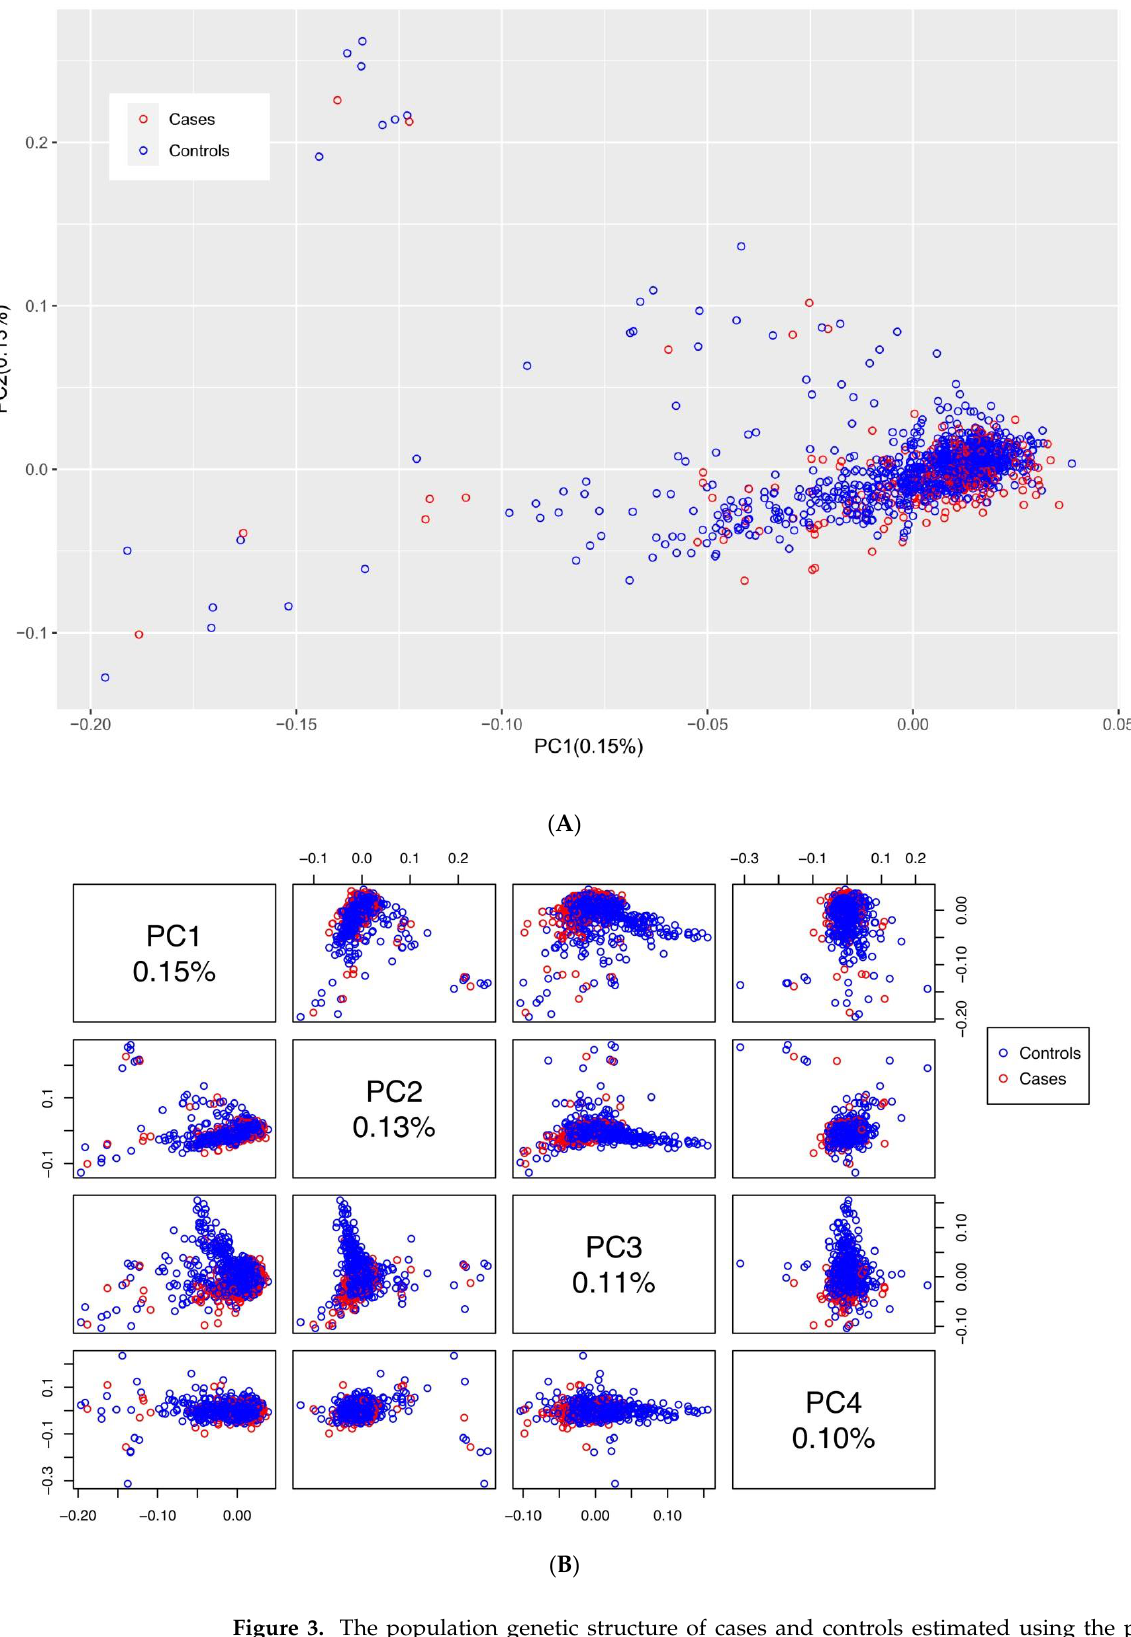
Figure 3. The population genetic structure of cases and controls estimated using the principal component analysis (PCA). The percentages of variance explained by the principal components (PC) are indicated for: ( A ) the first two PC; ( B ) the first four